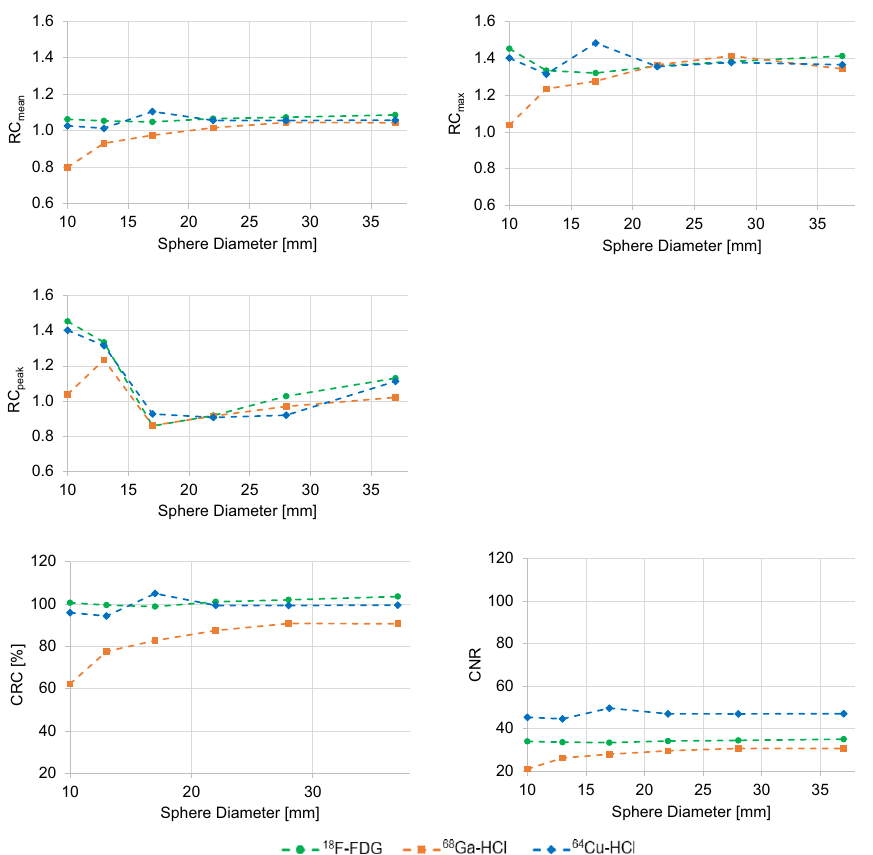
Fig. 3 Image quality parameters of the NEMA PET body phantom filled with 18 F-FDG, 68 Ga-HCl, or 64 Cu-HCl. Semiquantitative image quality specified as the mean, maximum and peak recovery coefficient (RC mean , RC max , and RC peak , respectively), percent contrast between each sphere and the background (contrast recovery coefficient (CRC)) and contrast–noise ratio (CNR) for each of the six spheres of the NEMA PET body phantom filled with 18 F-FDG, 68 Ga-HCl, or 64 Cu-HCl at a sphere-to-background activity concentration ratio of approximately 4:1 without the simulation of an obese patient (normal weight setup)